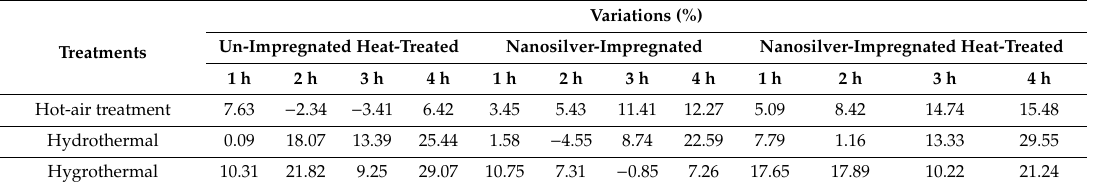
Table 1. Variations (%) based on the percent of change in the three hot-air, hydrothermal, and hygrothermal treatments at 1, 2, 3, and 4 h in beech specimens.